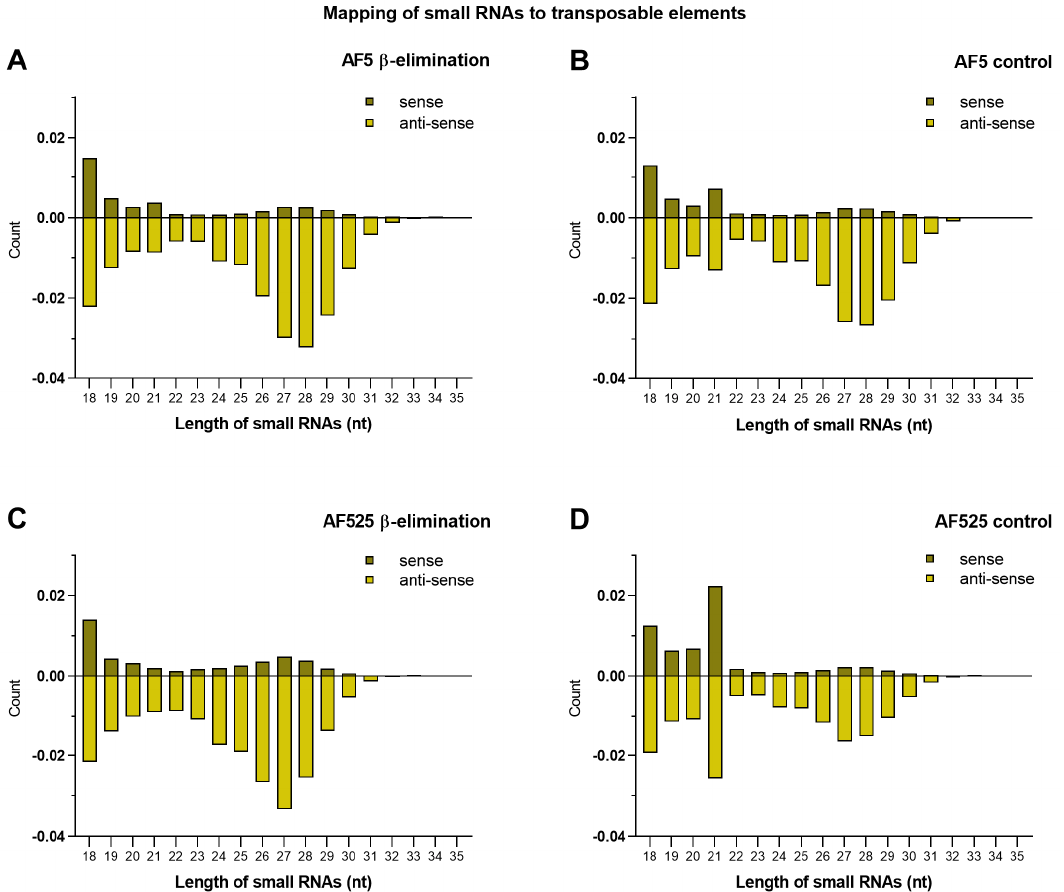
Figure 4. Length distribution of small RNAs from AF5 and AF525 cells mapping to TEs. Left panel side ( A , C ) shows treated samples of AF5 and AF525 cells, right panel side shows the results for untreated controls ( B , D ). x -axis displays the different lengths of small RNAs from 18 nt to 35 nt and y -axis displays the relative quantity of small RNAs normalized to clean reads. Positive numbers indicate RNAs mapping to the sense strand of TEs (dark green), while negative numbers indicate RNAs mapping to the anti-sense strand of TEs (light green). Two independent experiments were carried out, and the results of one representative experiment are shown here (run I).